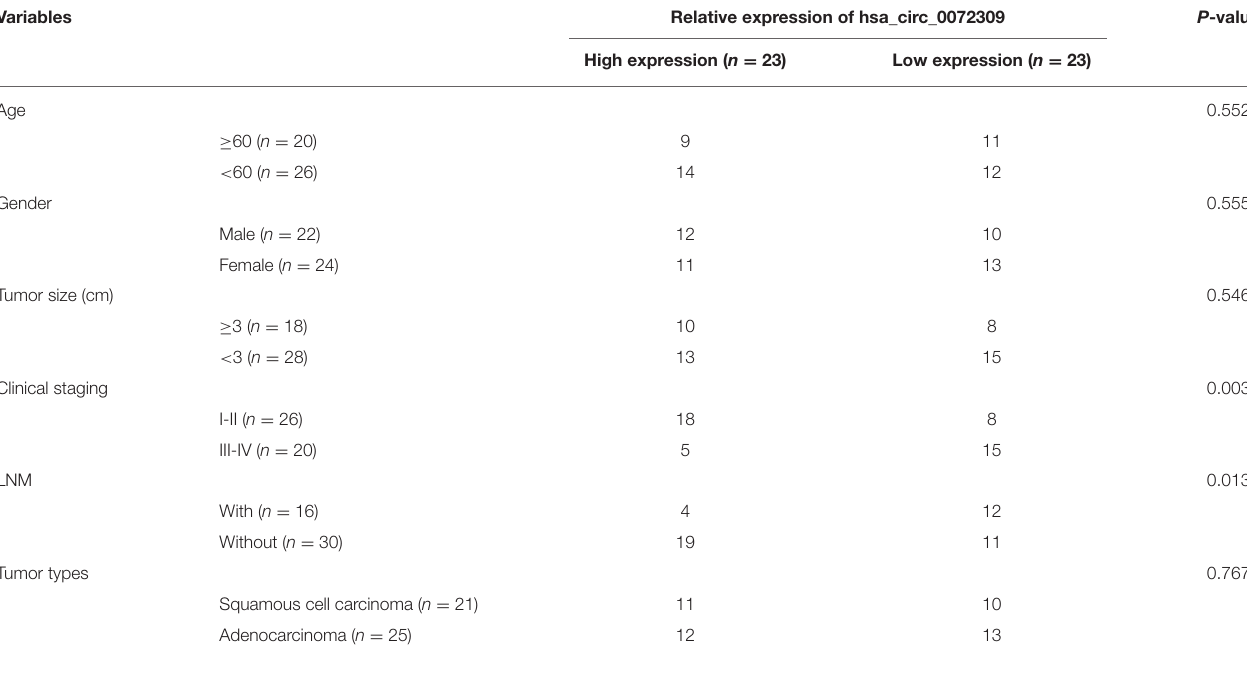
TABLE 3 | Connection between hsa_circ_0072309 and patient clinical